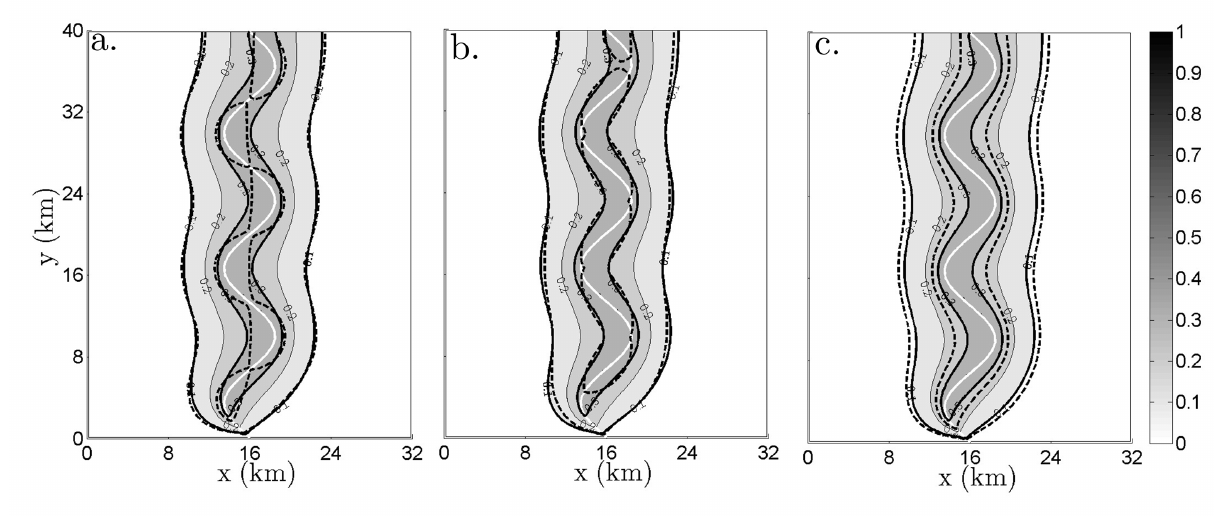
Figure 7. Normalized stream depletion due to pumping at every well location in the model domain for a homogeneous streambed after 20 years of pumping. The thick solid line represents the boundary of the region of infeasible locations for pumping wells if the = 0 . 003 m d − 1 . The thick dashed line represents the streambed is homogeneous with K r boundary of the region of infeasible pumping well locations for ( a ) heterogeneous K (high r = 0 . 003 m d − 1 ; ( b ) heterogeneous K flow regime) with mean K (low flow regime) with r r = 0 . 003 m d − 1 ; and ( c ) homogeneous K = 0 . 004 m d − 1 mean K with mean K r r r